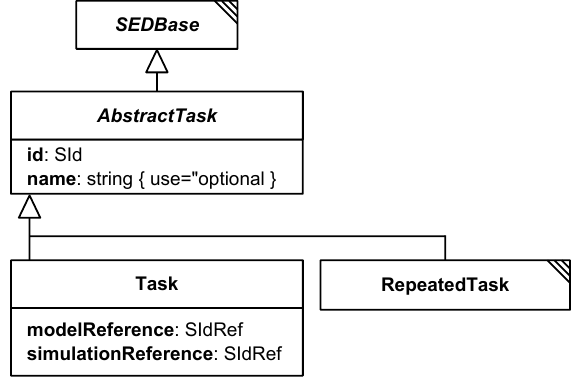
Figure 2.12: The SED-ML Abstract Task class